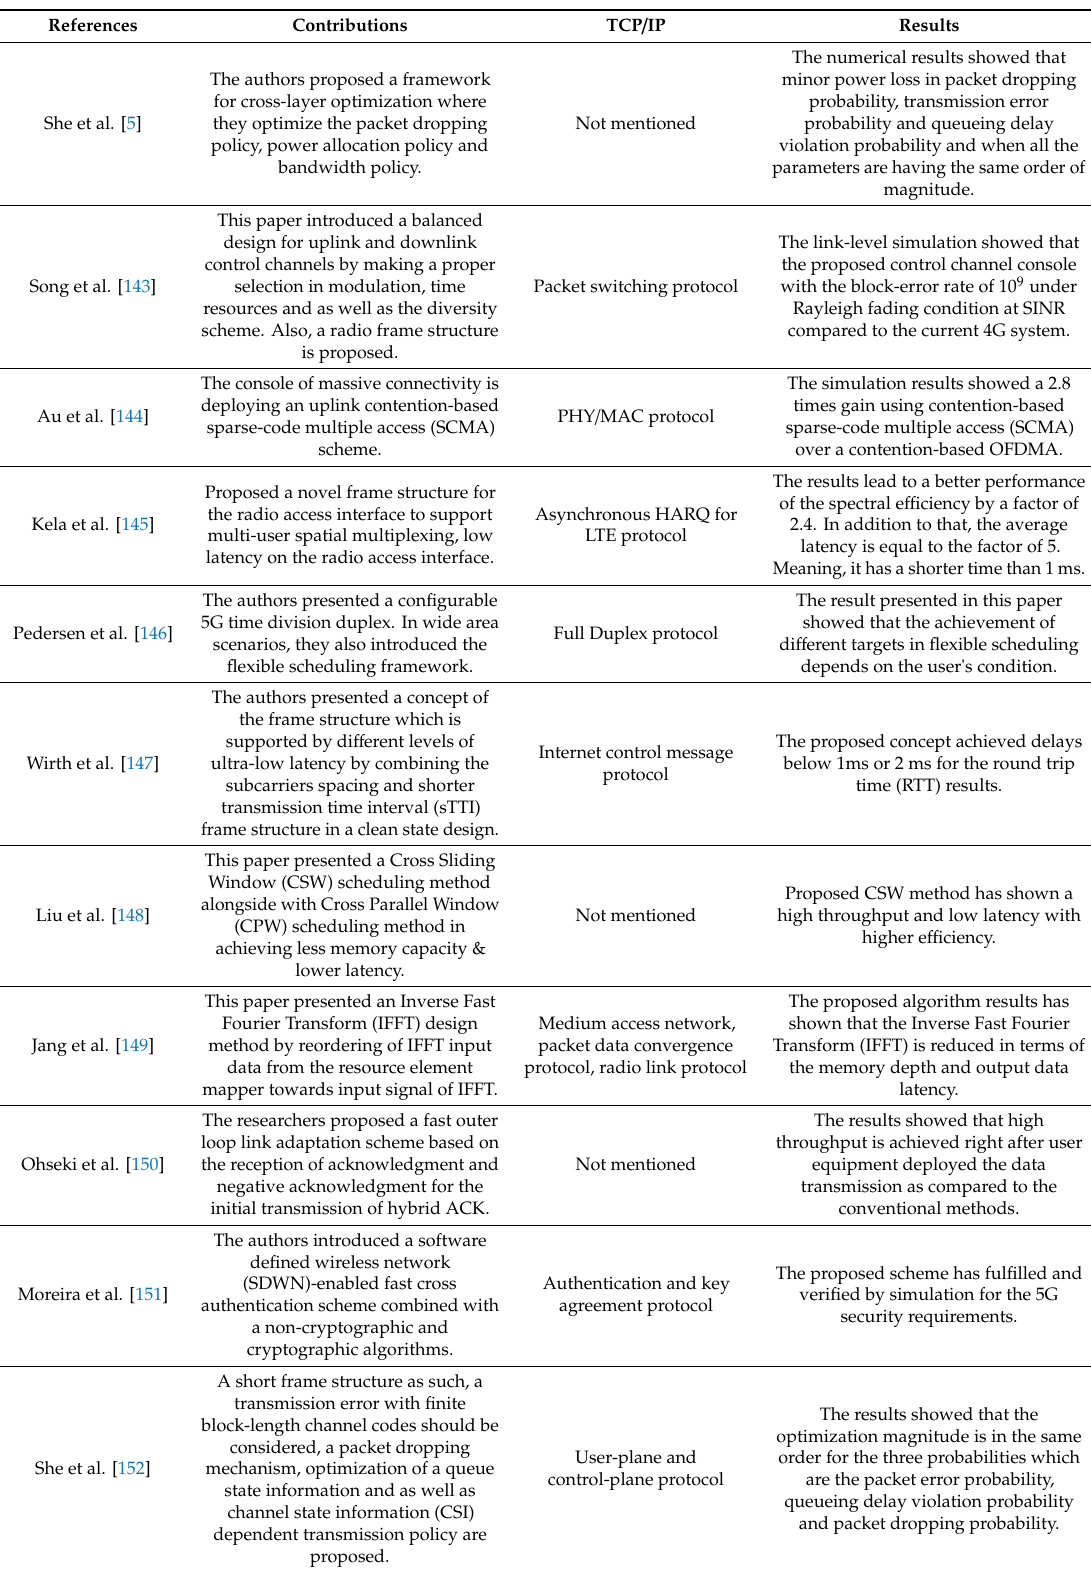
Table 5. Summary of previous works on the cross-layer